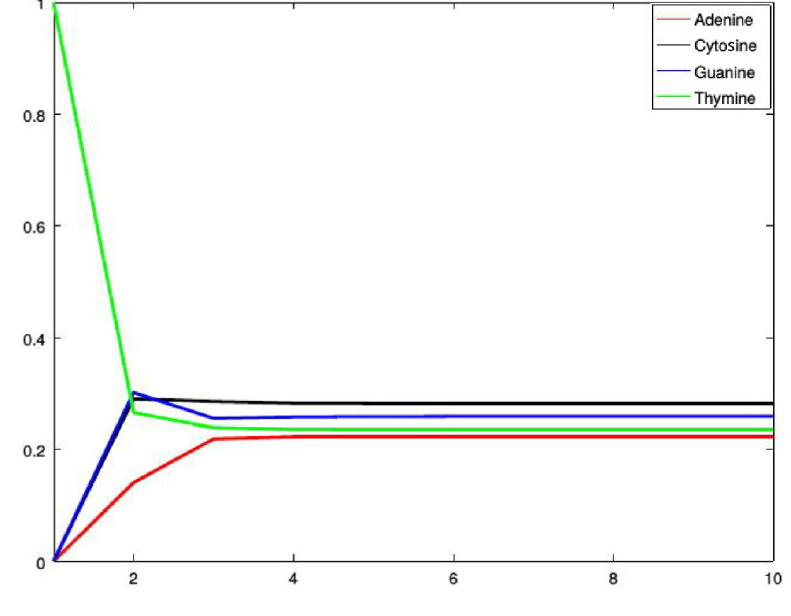
Figure 5. Probabilities of occurrences of the bases in consecutive steps starting from